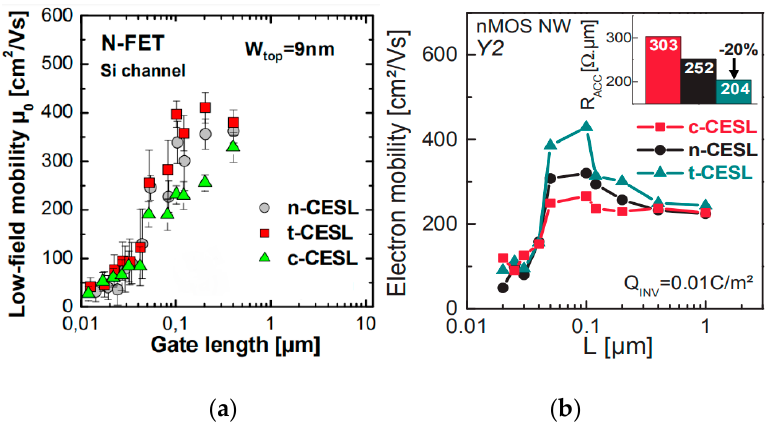
Figure 31. NMOSFET electron mobility vs. contact etch stop layer (CESL) technology, ( a ) in 9 nm n-FET NW. A better mobility is observed under tensile CESL [187] and ( b ) Electron mobility vs. L for different CESL in nanowires. Inset: extracted access resistance [188].